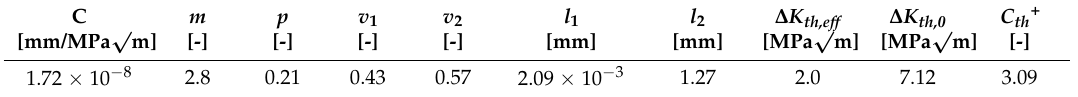
Table 1. Crack growth material parameters of fitted SENB experiments.